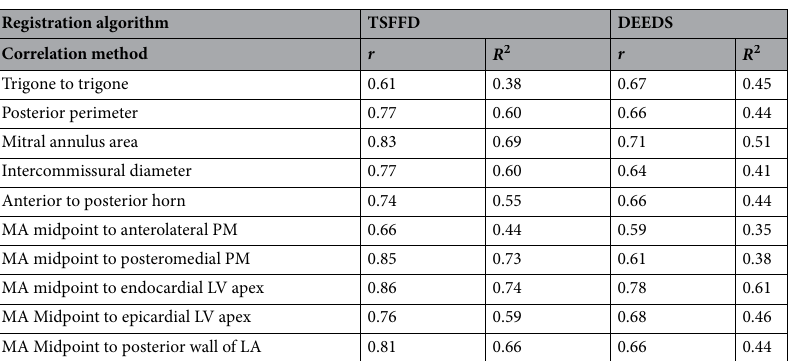
Table 1. Manual measurements from analysis of anatomical landmarks are compared to measurements calculated from automatic tracking of the same landmarks using our two registration algorithms. The results show a moderate or strong correlation for majority of these measurements. r = Pearson correlation coefficient 2 and R = regression analysis illustrate the correlation between manually and automatically calculated